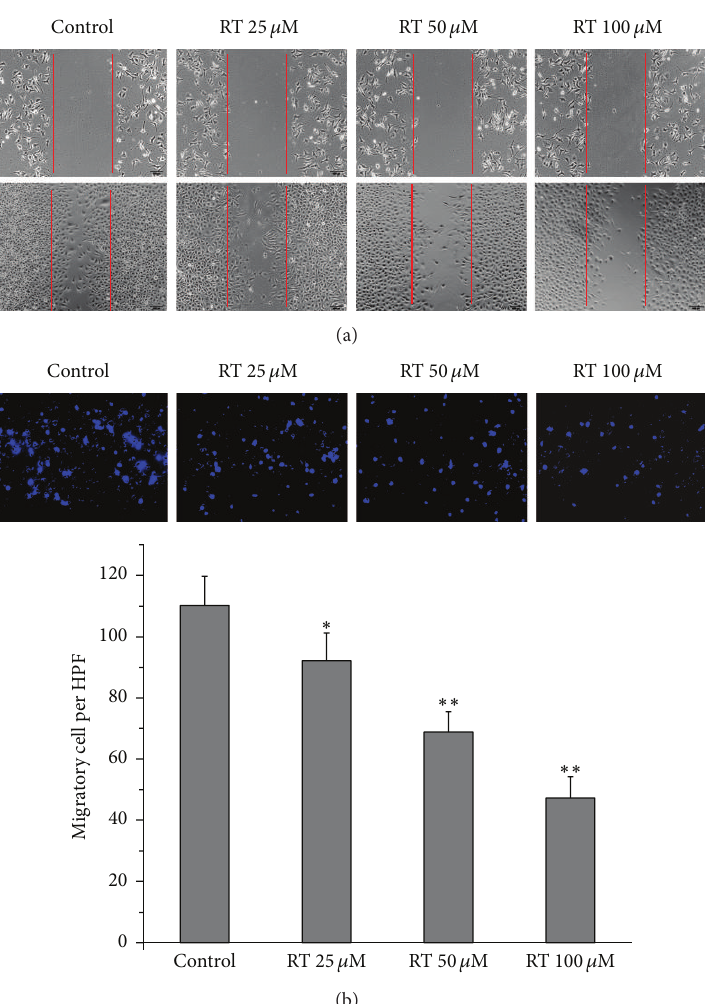
Figure 6: Effect of rutin on cell migration and invasion capability. The representative pictures in cell wounding and migration assay. (a) The pictures show the migration of LAN-5 cells in the martrigel surface after 48 hr of scrape in different groups. The dot line shows the initial start point where the cell began the migration process. (b) The pictures show the transwell assay. The cells that have migrated through the pores to the lower surface of the membrane were counted under microscope. All experiments data are expressed as means ± SEM, of the three measurements ∗ 𝑃 < 0.05 ; ∗∗ 𝑃 < 0.01 compared to